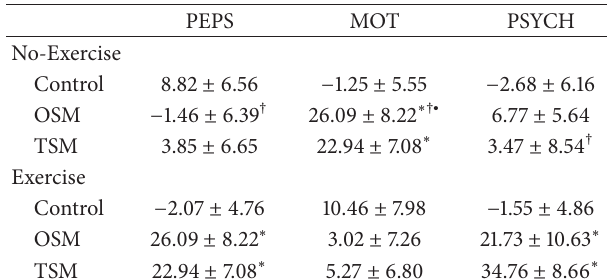
Table 3: Mental state